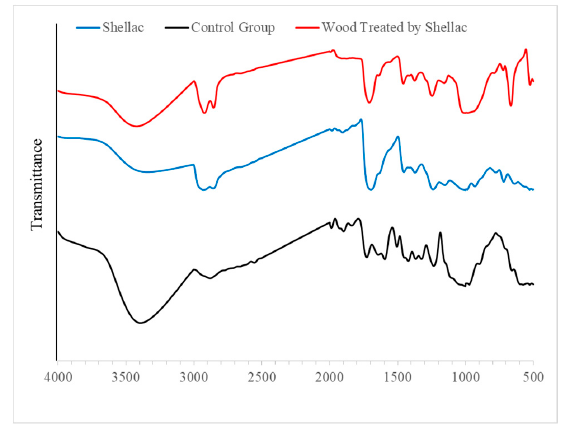
Figure 3. FTIR spectra of the samples treated by shellac and those in the control group.